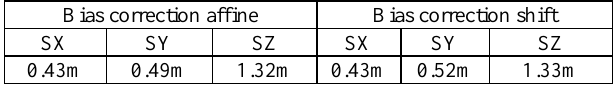
Table 4. 3D-determination of ground control points, Pléiades,